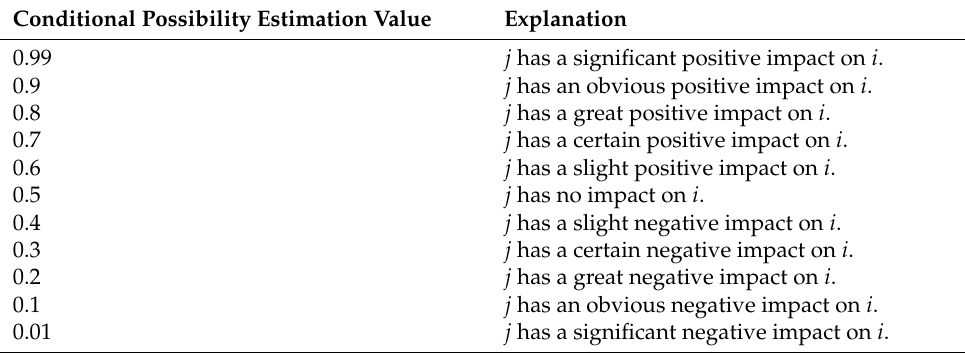
Table 2. Conditional probability estimation